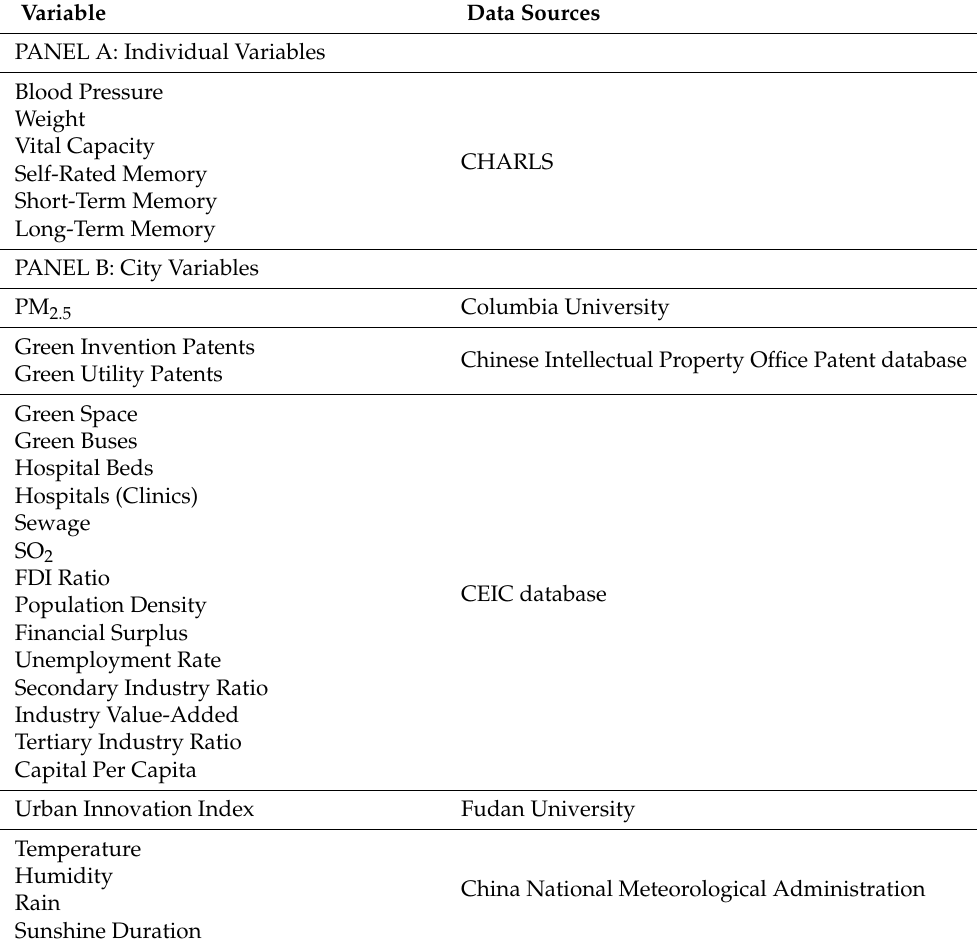
Table 1. Data sources for primary